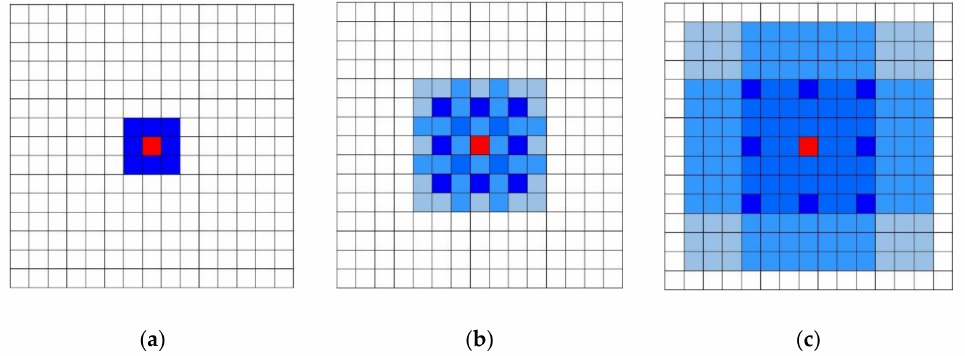
Figure 3. Diagram of hybrid dilated convolutional neural network with different expansion rates: ( a ) the diagram of HDC with expansion rate 1; ( b ) the diagram of HDC with expansion rate 2; ( c ) the diagram of HDC with expansion rate 3.